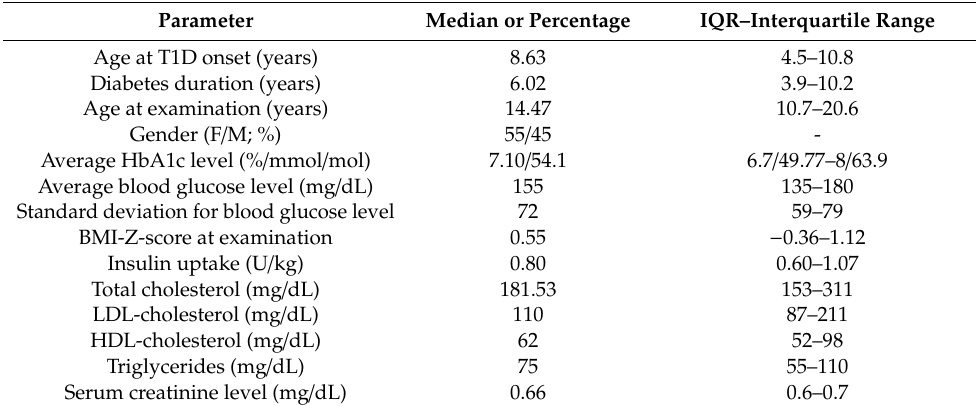
Table 1. Characteristics of the study group of patients with type 1 diabetes